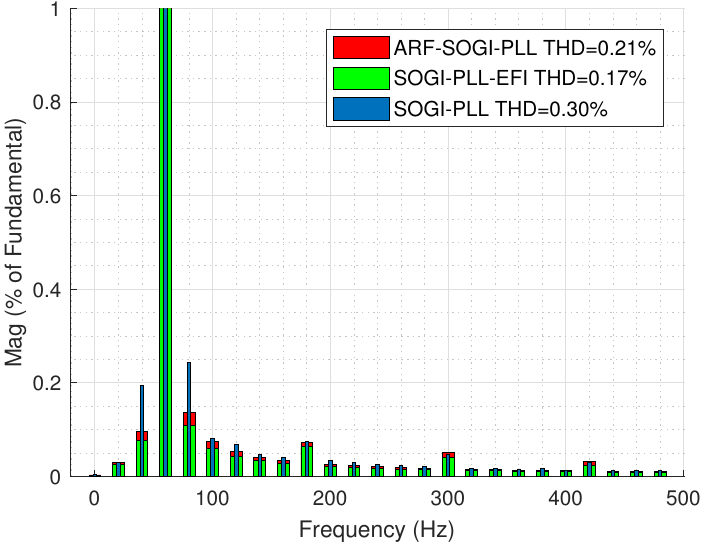
(cid:16) (cid:17) ω t (cid:48) for k αβ = 0.5 and k = 0.5 and an input THD of 4.99%.